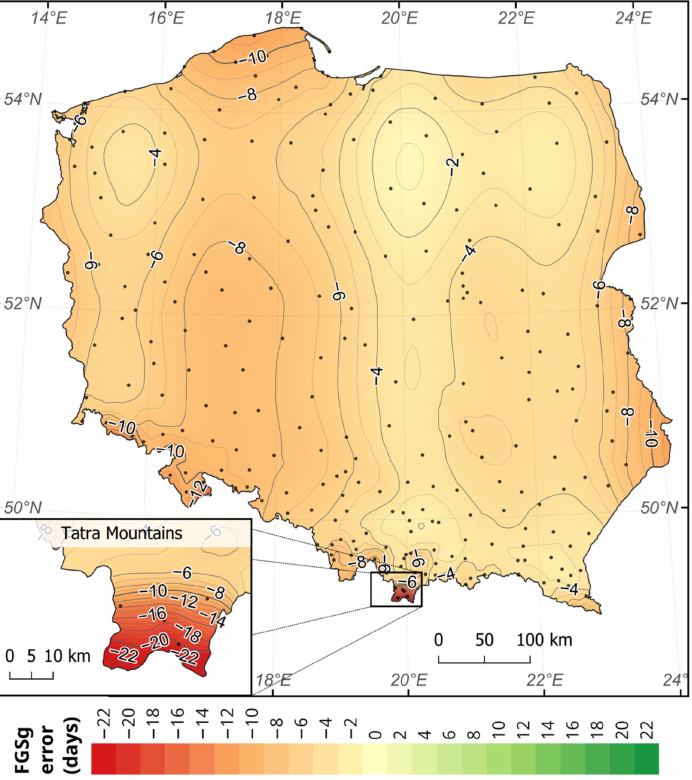
Figure 4. Error of the determination of FGSg in Poland based on data from the WorldClim service as- sessed using the correction model, based on a comparison with FGSr, determined from measurements from 245 meteorological stations (black